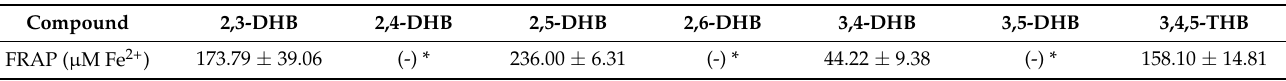
Table 3. FRAP antioxidant activity of tested hydroxybenzoic acids at a concentration of 50 µ M (methanolic solutions). Mean values from three independent experiments ± SD are shown.